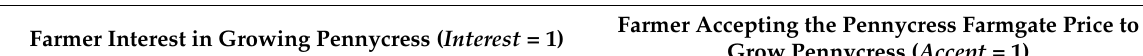
Table 5. Estimated probit models of interest in and willingness to accept the pennycress price to grow pennycress among row crop farmers surveyed in seven US states and estimated marginal